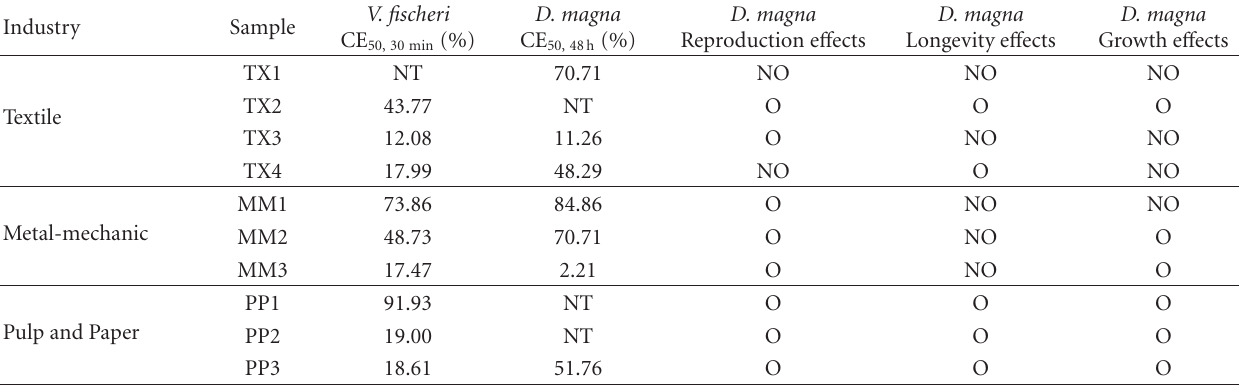
Table 6: Summary of acute e ff ects on Vibrio fischeri and Daphnia magna and chronic e ff ects (reproduction, longevity, and growth) in Daphnia magna exposed to soluble fractions of textile, metal-mechanic, and pulp and paper solid waste.